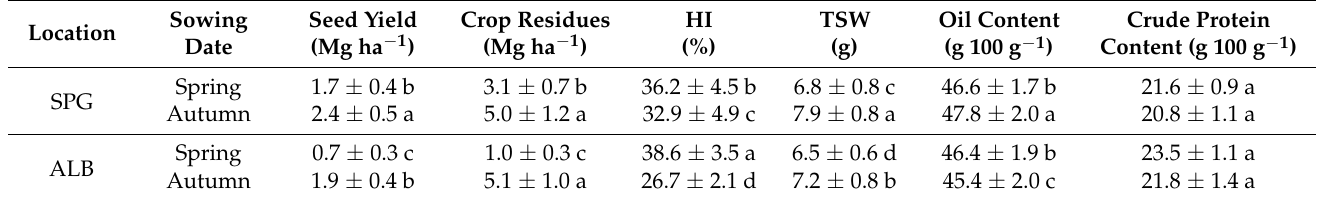
Table 7. Interaction effects of location (SPG and ALB) and sowing date (spring and autumn) on seed yield, vegetative biomass, harvest index (HI), thousand seed weight (TSW), oil and protein concentrations of linseed. Data refer to mean values ± standard